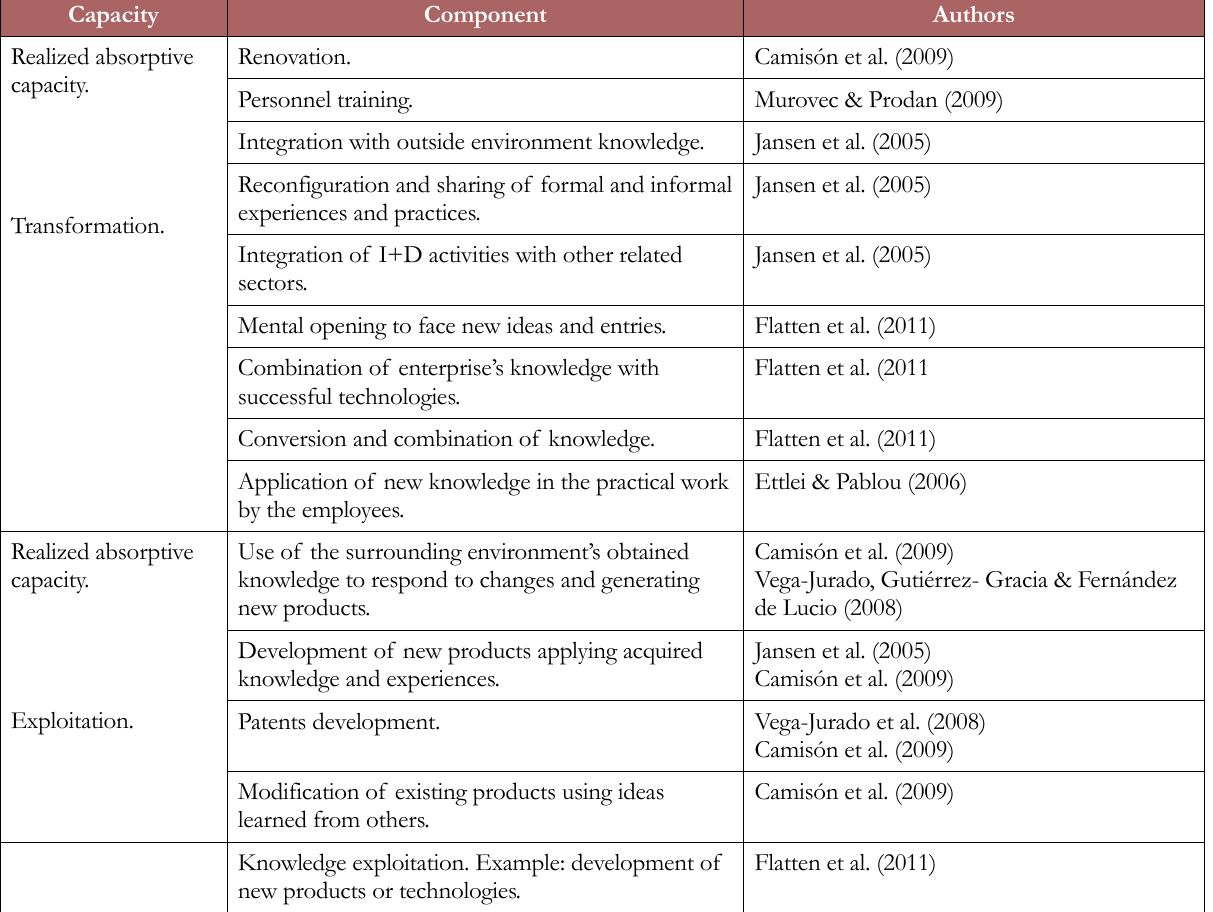
Table 1. Realized absorptive capacity: analysis